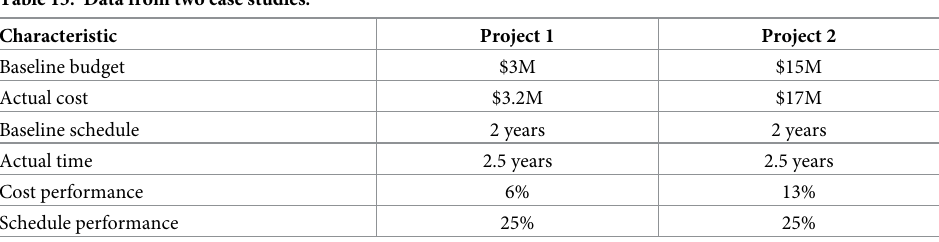
Table 13. Data from two case